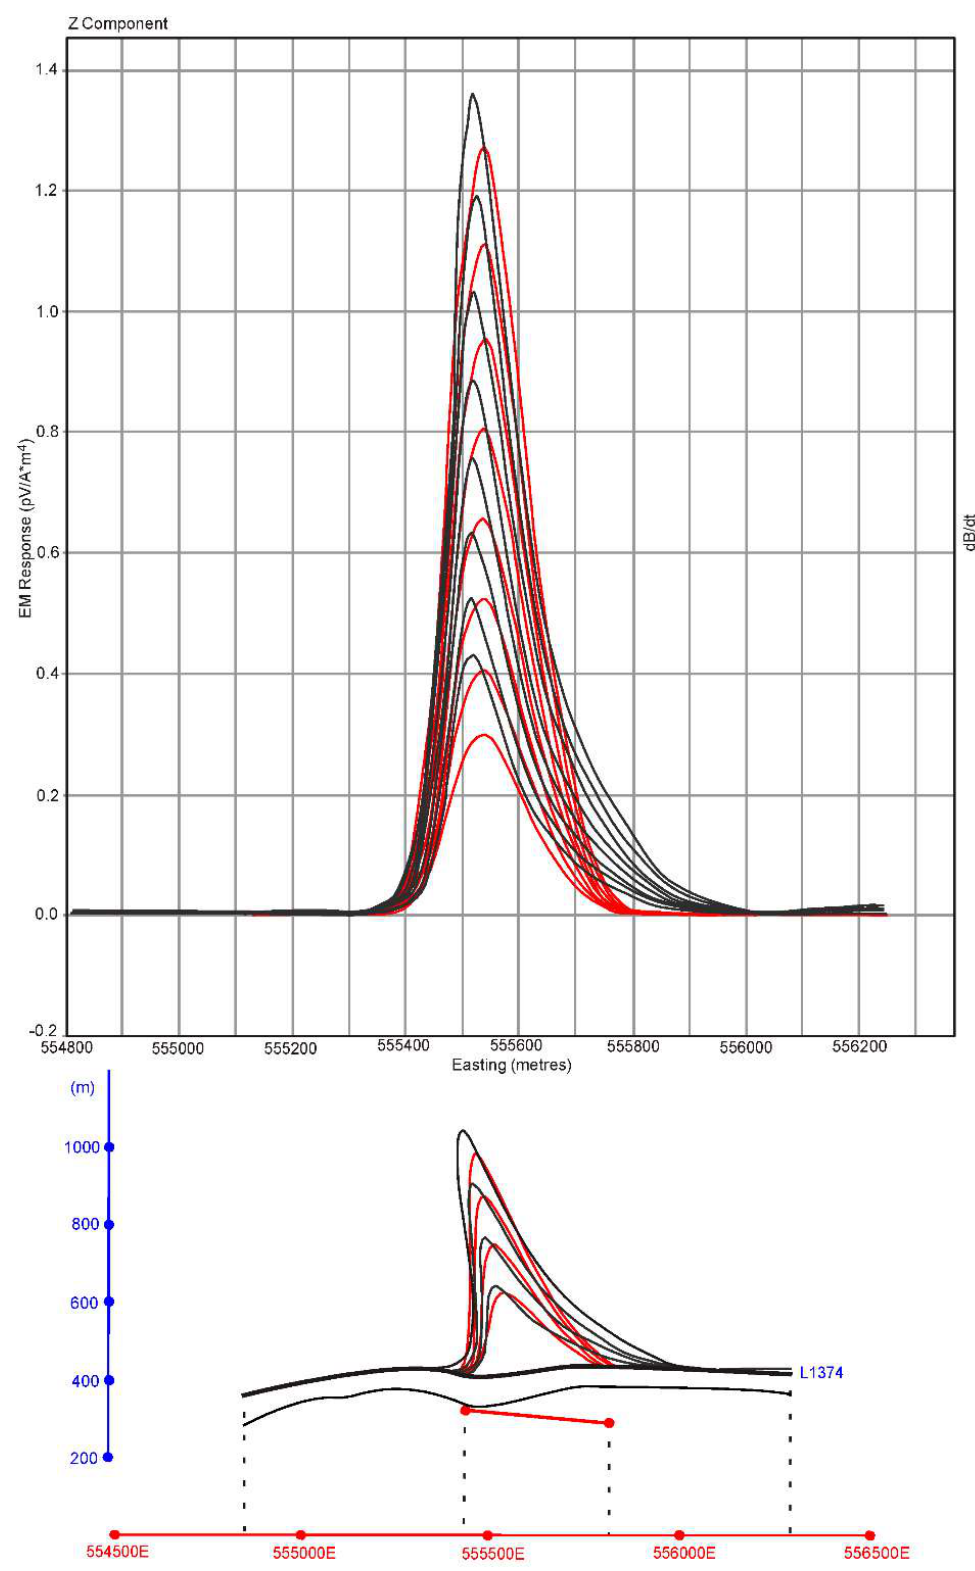
Figure 9. Maxwell thin plate modelling of the L1374-1 Arinteiro zone, facing north. The black lines are the field data of the Z component of the VTEM flight line L1374-1 and the red lines indicate the signals from the modelled plate. The top of the modelled conductor is close to surface and dips 5° east, with a conductance of 104S. It has a strike length of 375 m.